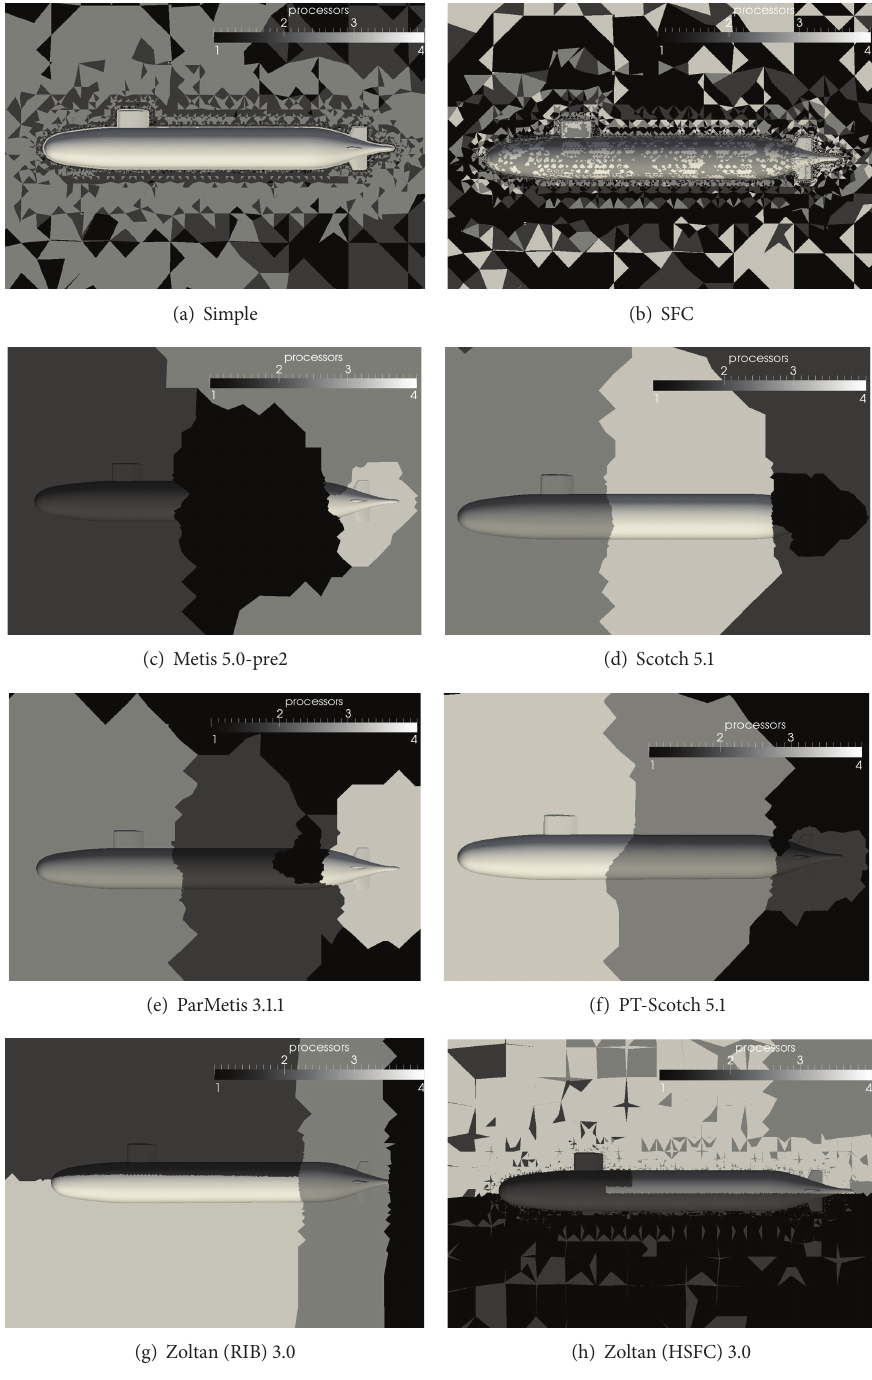
Figure 4: Comparisons of mesh partitioning.